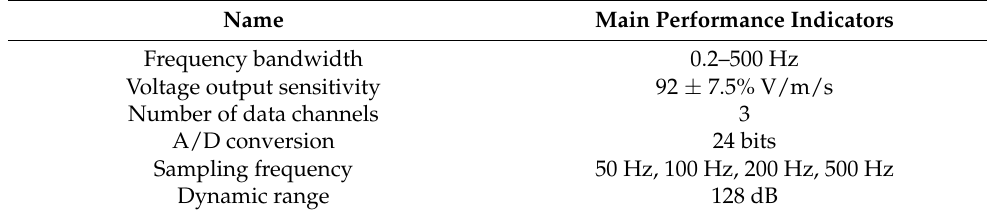
Figure 8. Waveforms of microtremor signals at observation stations in vertical direction.